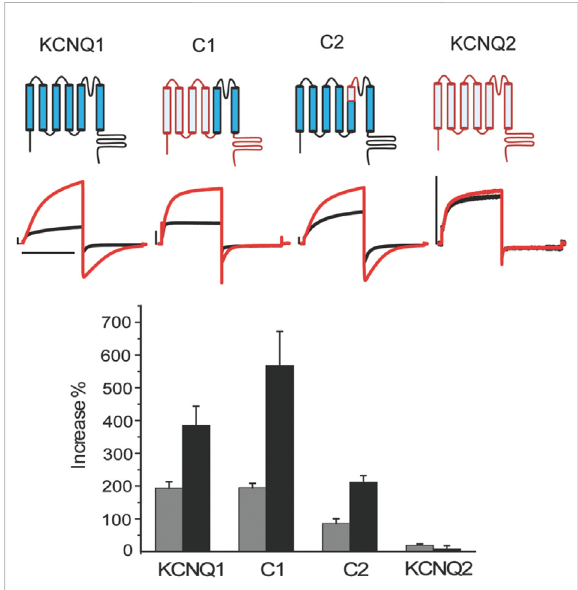
FIGURE 1 KCNQ1 pore domain is the main drug site for ML277. Top panel) schematic structure of wt KCNQ1 (blue), WT KCNQ2 (red), and chimera channels C1 and C2. C1 consists of KCNQ1 S5-pore- S6 and KCNQ2 S1-4 and N, C-termini. C2 is mostly KCNQ1 except for the top of S5 and a small portion of the